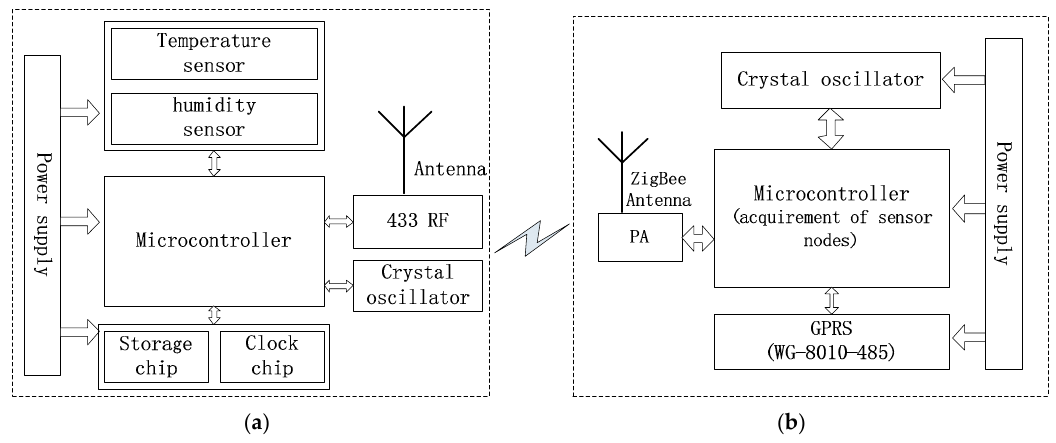
Figure 2. Block diagram of the WSN nodes. ( a ) Block diagram of the sensor node; ( b ) Block diagram of the network coordinator. PA, power amplifier.